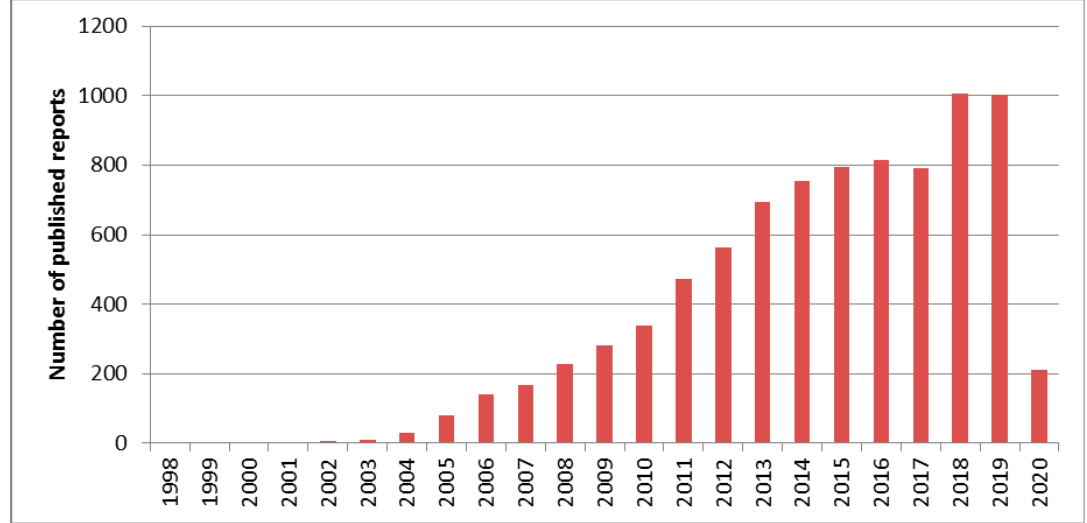
Figure 1. Number of published reports on the use of nanomaterials in sample preparation; source: PubMed.